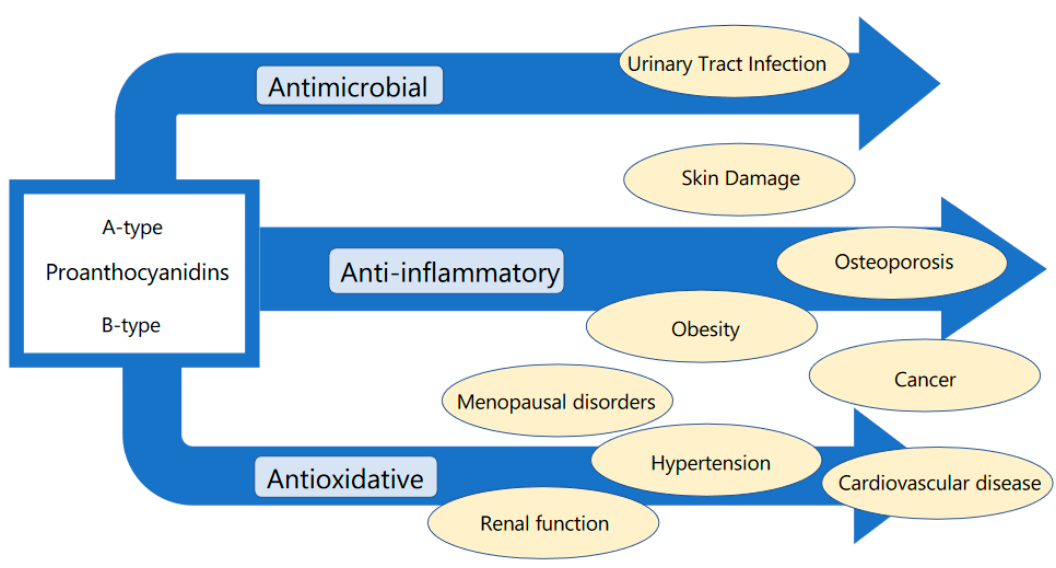
Figure 2. Relationship between the effect of proanthocyanidins and disease field.